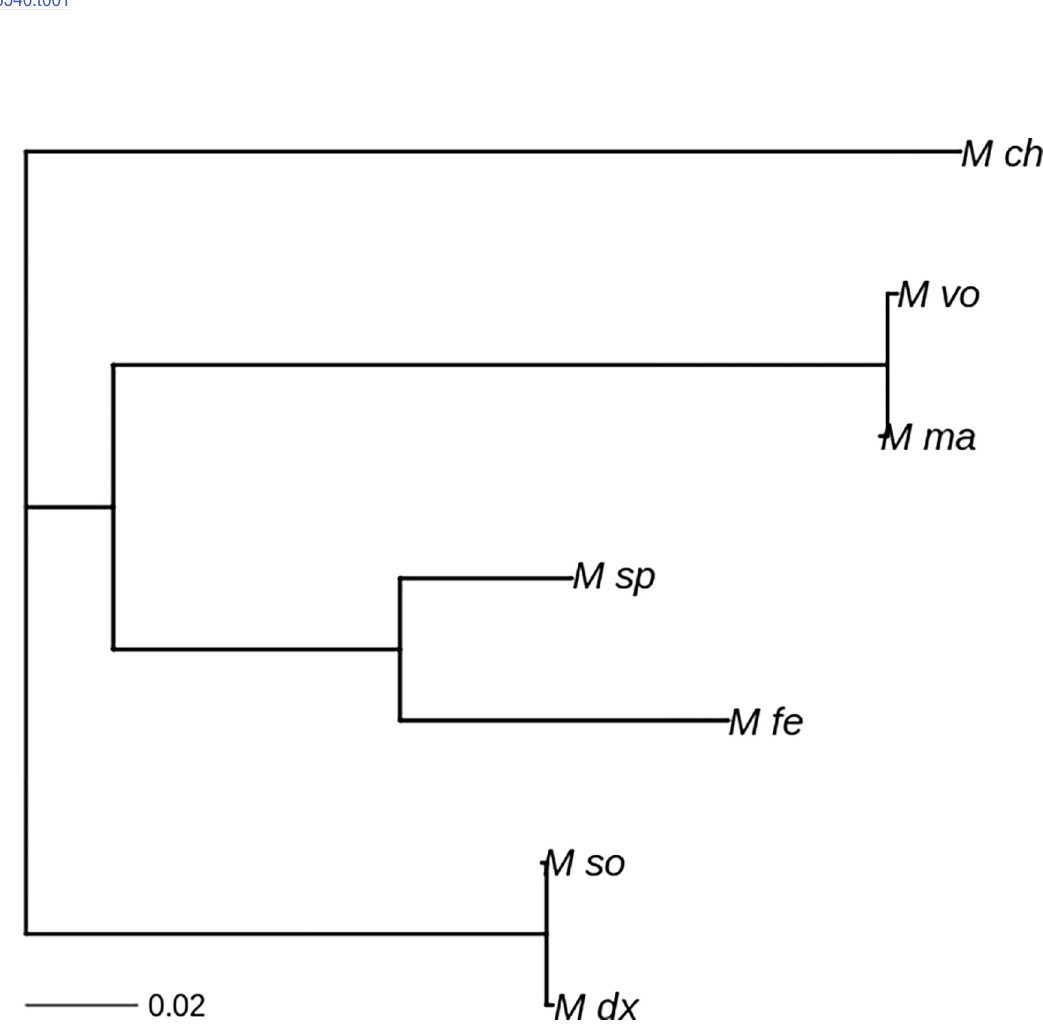
Fig 4. Phylogenetic tree obtained using 72 private SNPs for Macrobrachium species: M . dux , M . macrobrachion , M . sollaudii , M . vollenhovenii , M . chevalieri; M . felicinum , and M . sp . The phylogenetic tree for these Macrobrachium species using a larger set of SNPs (N = 1,814) is provided in